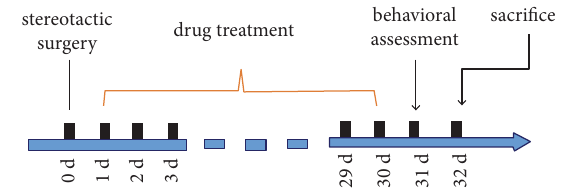
Figure 1: Schematic diagram of the study. Te timeline and se- quence of treatments conducted are